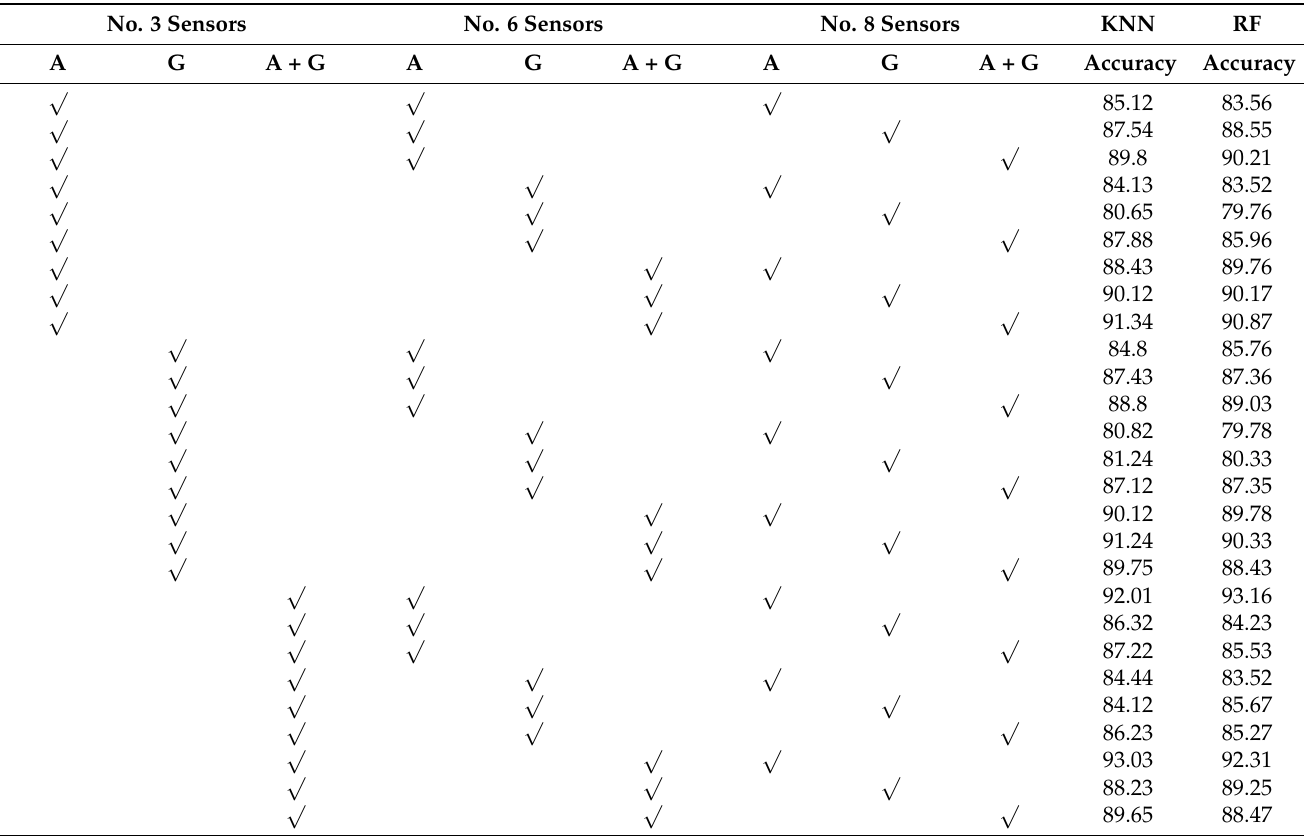
Table 7. Accuracy Evaluation of Three-Position Fusion Inertial Sensor Recognition